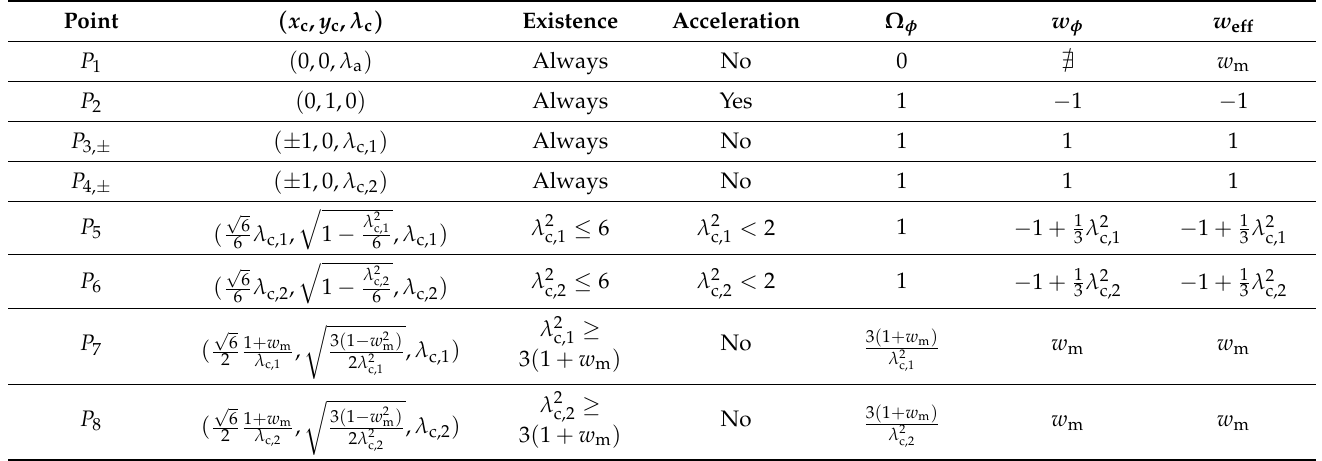
Table 3. Critical points for the dynamical system with the broken exponential-law. λ a represents an arbitrary value of the parameter λ . For each critical point we present its coordinates, the conditions for existence and acceleration and the corresponding values of the scalar field energy density Ω φ and equation of state w φ and the total equation of state of the system w eff .